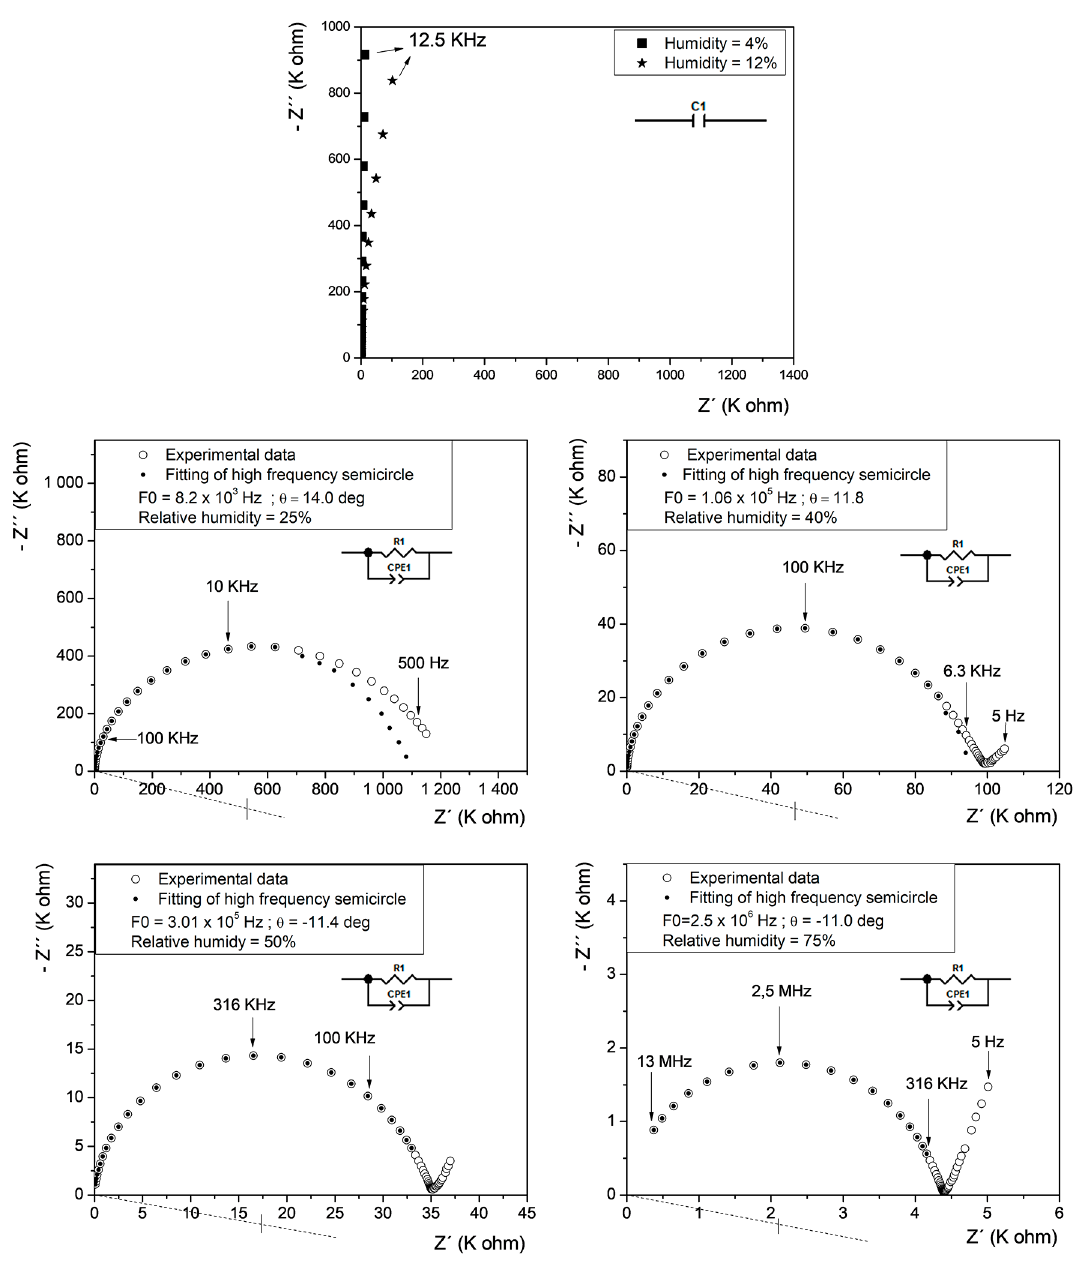
Figure 9. Equivalent circuits and Nyquist plots at room temperature of composition A sintered at 1350ºC with varying relative